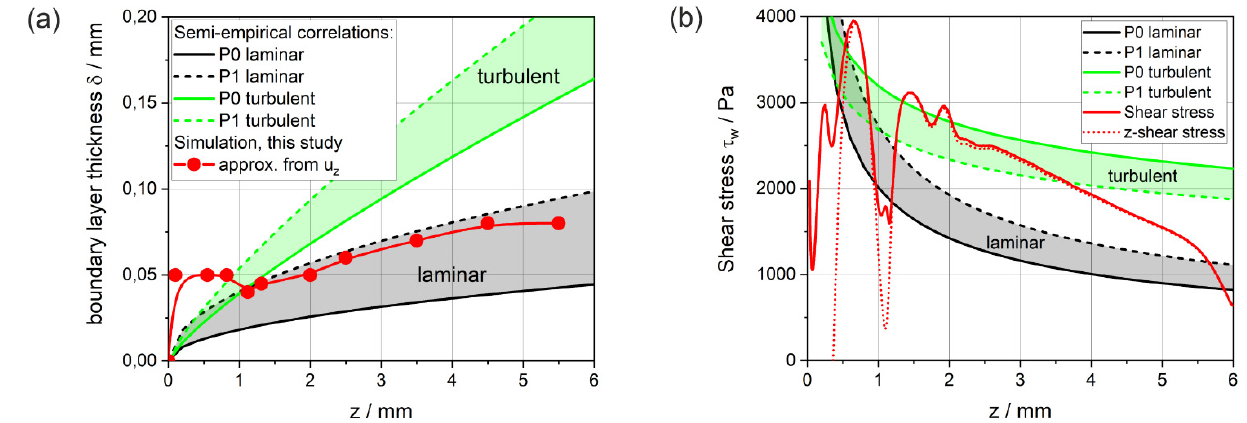
Figure 8. Comparison of results from semi-empirical correlations determined in [35] and simulation results of the current study at the contact line of front and edge for ( a ) boundary layer thickness, ( b ) wall shear stress.